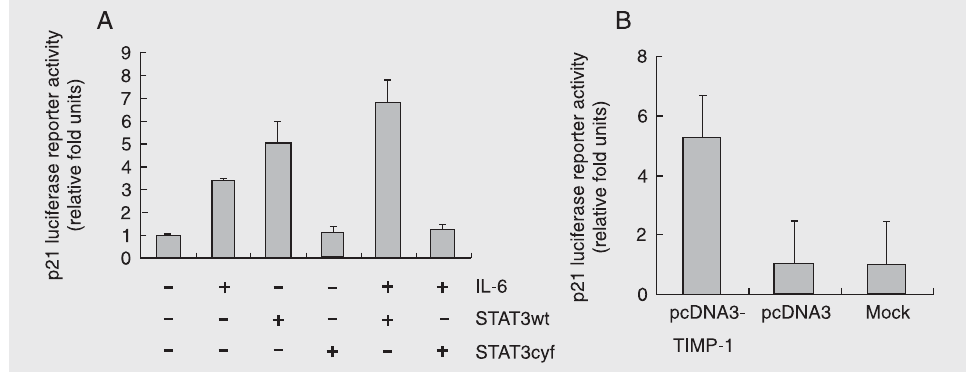
Figure 4. Up-regulation of p21 induced by tissue inhibitor of metalloproteinases (TIMP-1) and interleukin-6 (IL-6) in BEL-7402 cells analyzed by the luciferase assay. A , Cells were transfected with p21(Waf1) reporter, co-trans- fected together with pcDNA3-STAT3wt or pcDNA3-STAT3cyf constructs. The cells were then treated or not with IL- 6. B , Cells were transfected with p21(Waf1) reporter, co-transfected together with pcDNA3-TIMP-1 or pcDNA3 as an empty parental vector control. Mock was a blank control representing the cells transfected by nothing. Each group was co-transfected with the ß-gal reporter plasmid to normalize the transfection